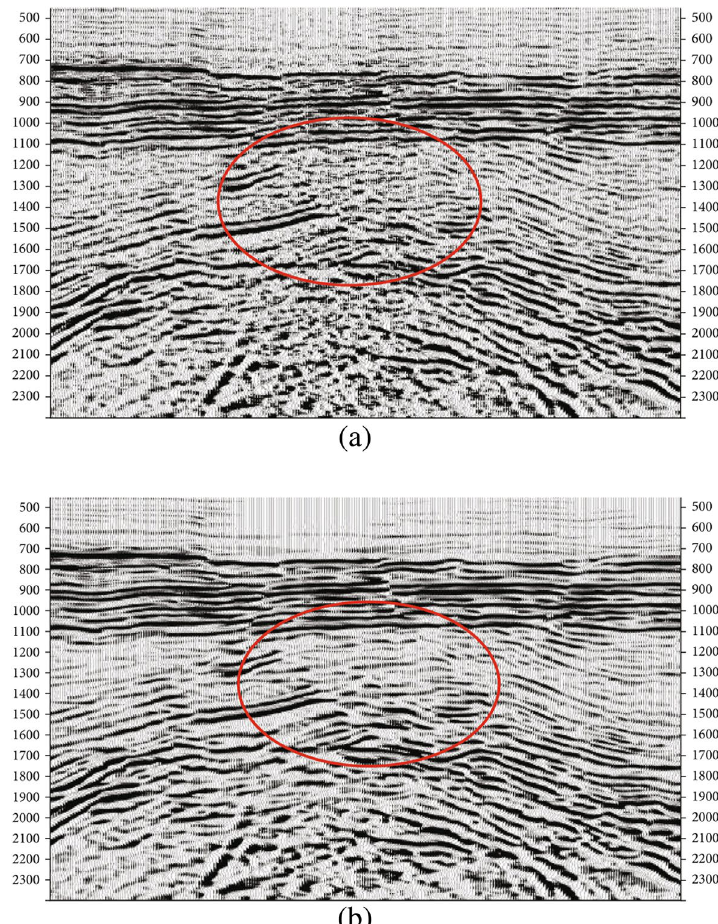
Fig. 8 Migration profiles. a Original noisy section. b Denoised section by the proposed